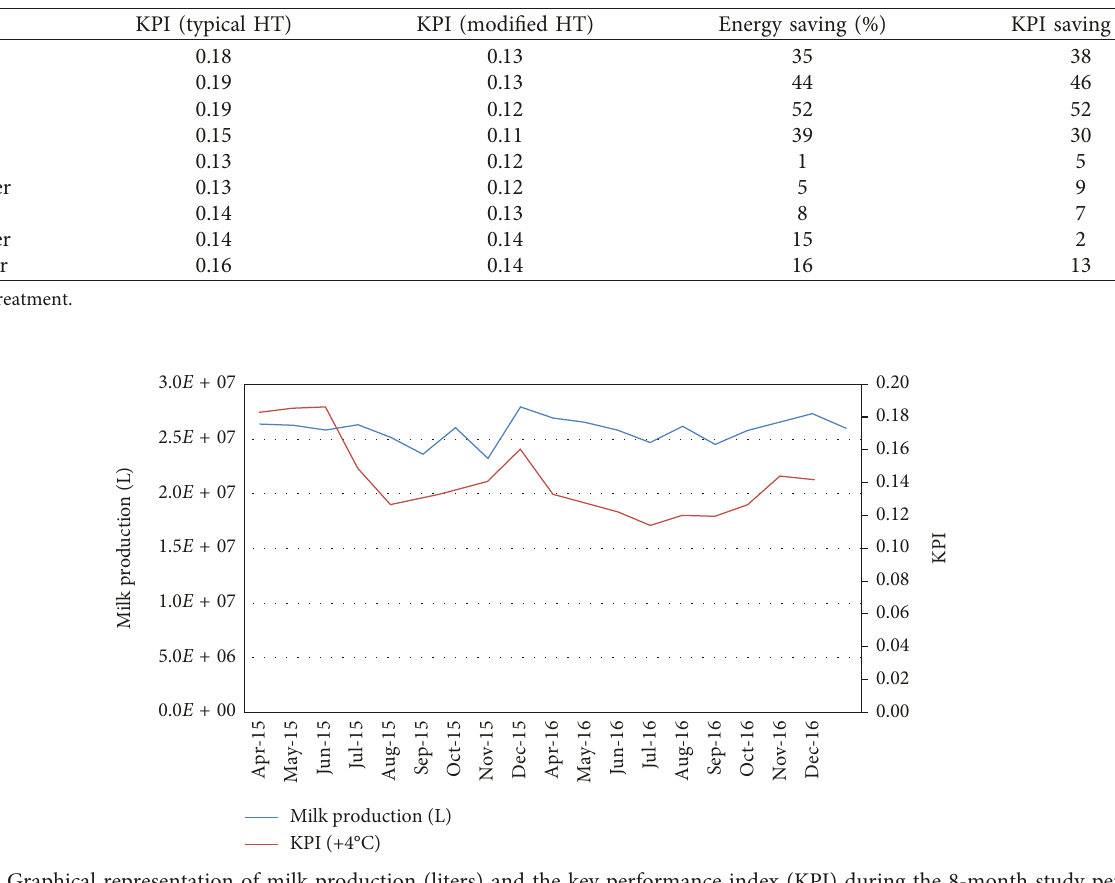
Figure 2: Graphical representation of milk production (liters) and the key performance index (KPI) during the 8-month study period, comparing 2015 (+4 ° C) and 2016 ( 4 ° C).